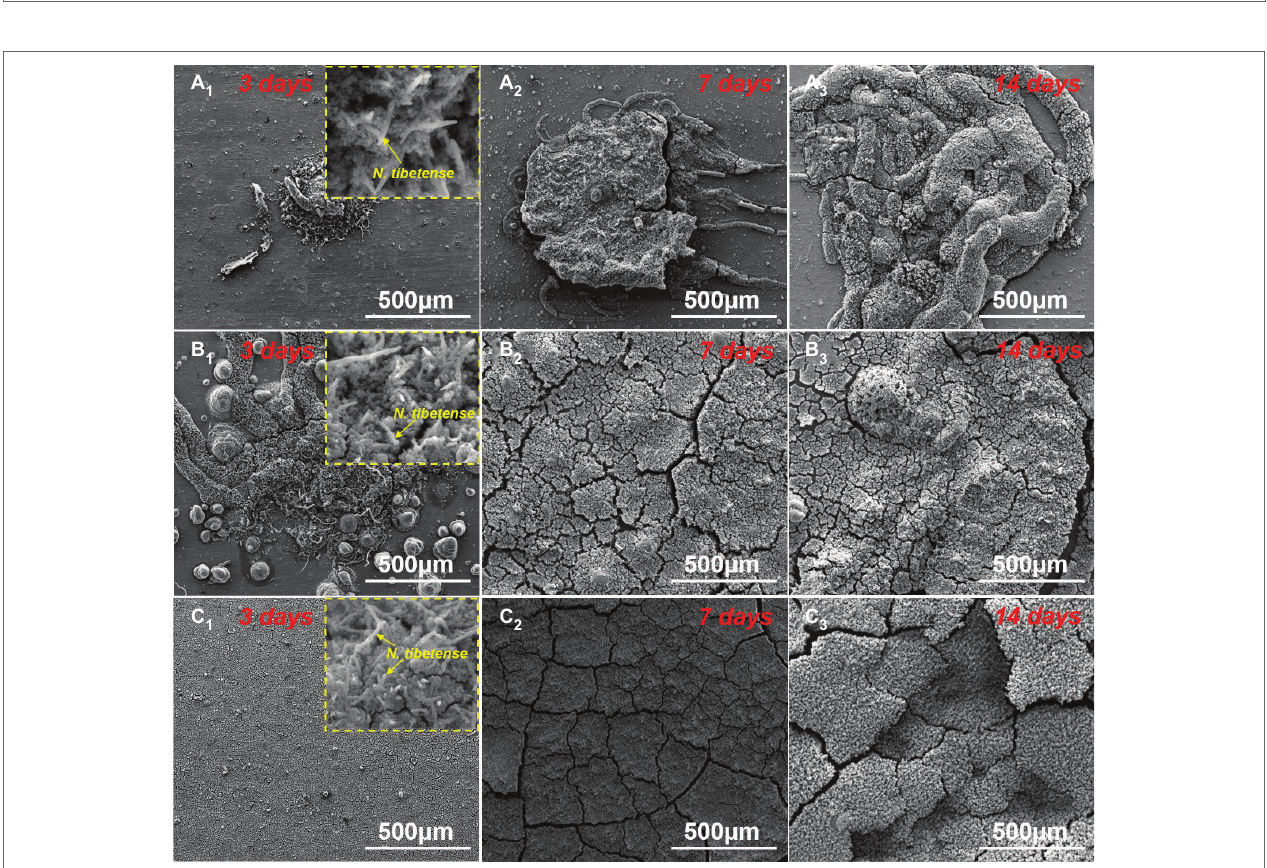
FIGURE 2 | SEM images of sample surfaces (A 1 –C 1 ) before and (A 2 –C 2 ) after removing the corrosion products after 14 days of immersion in sterile media with different